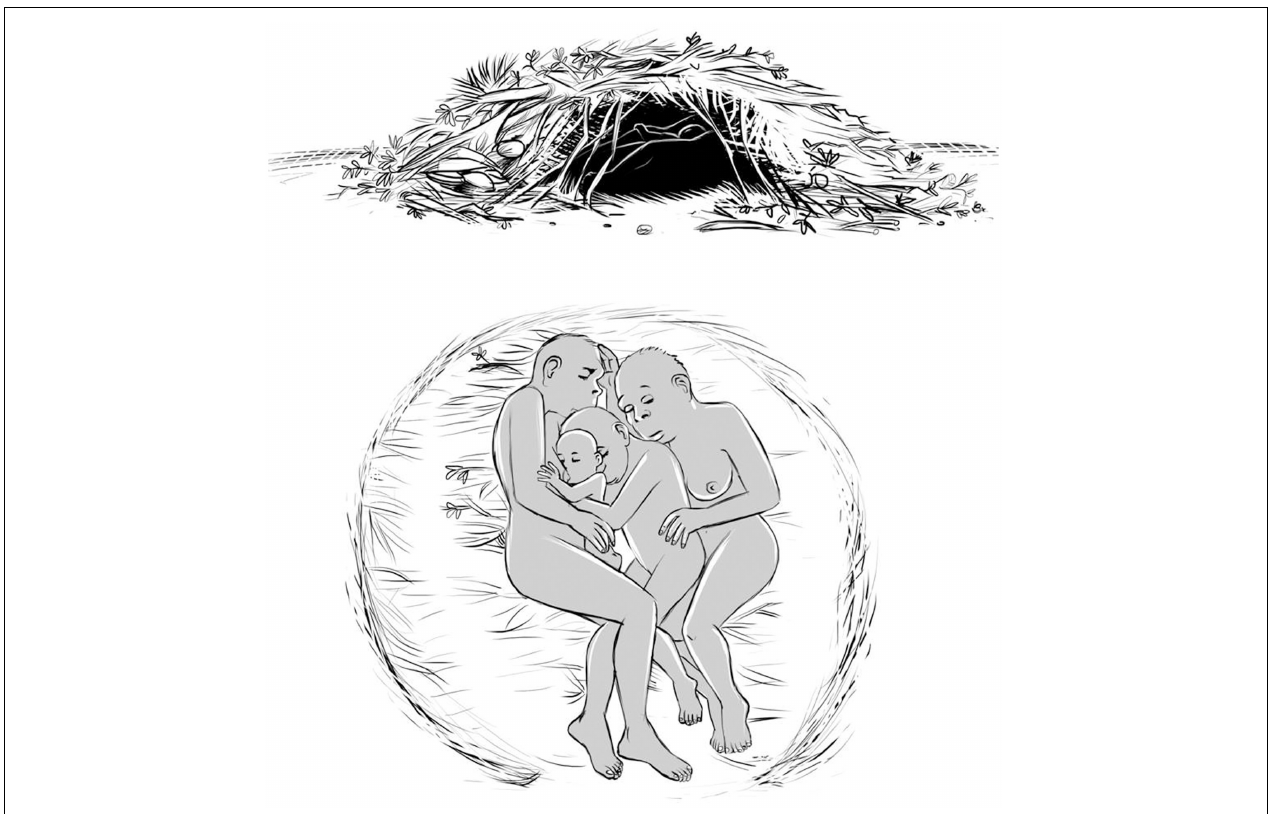
FIGURE 8 | Sketch of the possible solution for earlier naked hominins: huddle with female family for thermoregulation in a primitive shelter of natural materials (done by Carlinhos Muller, following my original idea, see details in the